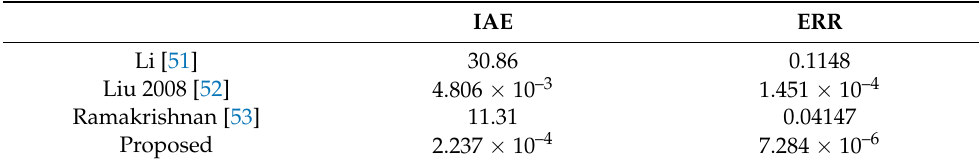
Figure 21. The Bode plots for process G P5 . Table 11. The criteria values for the process G P5